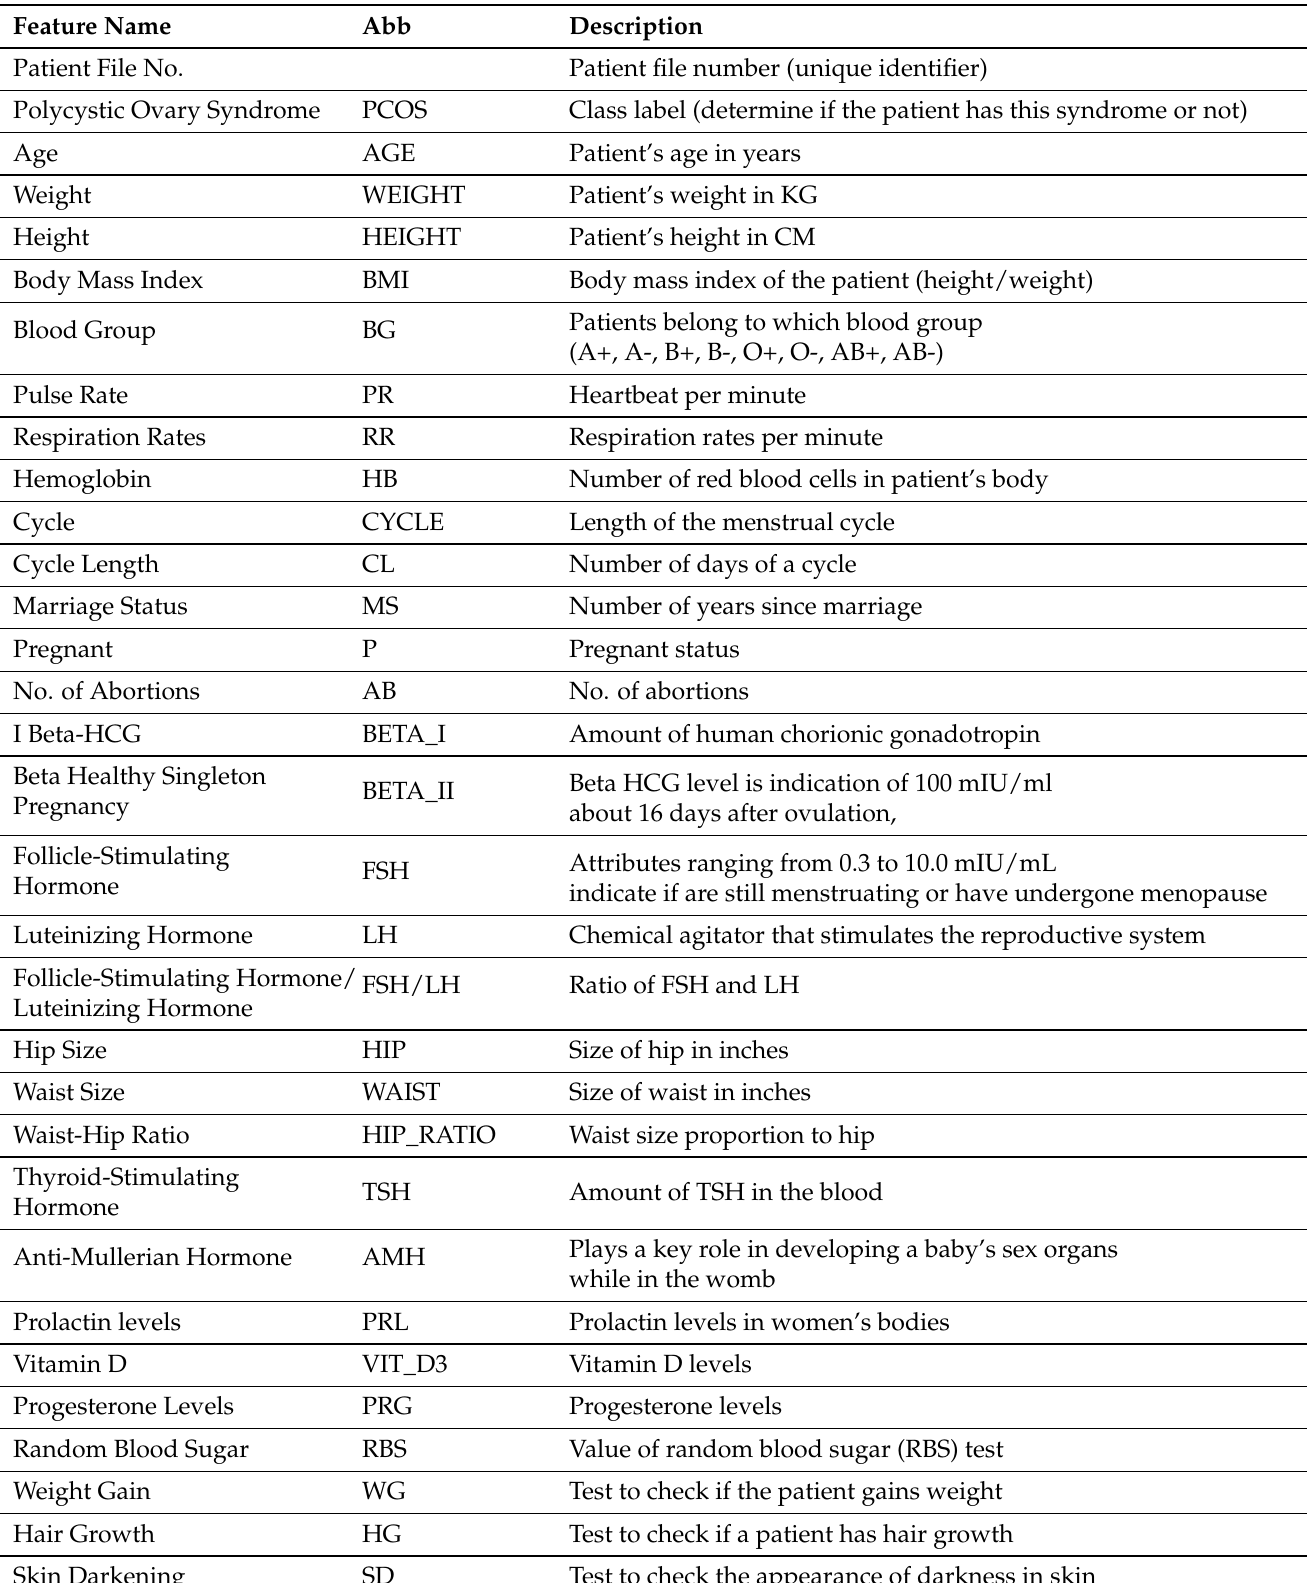
Table 1. Dataset features description